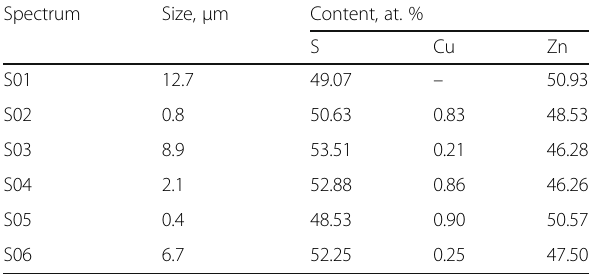
Table 1 Element composition of ZnS:Cu particles, obtained by SHS method